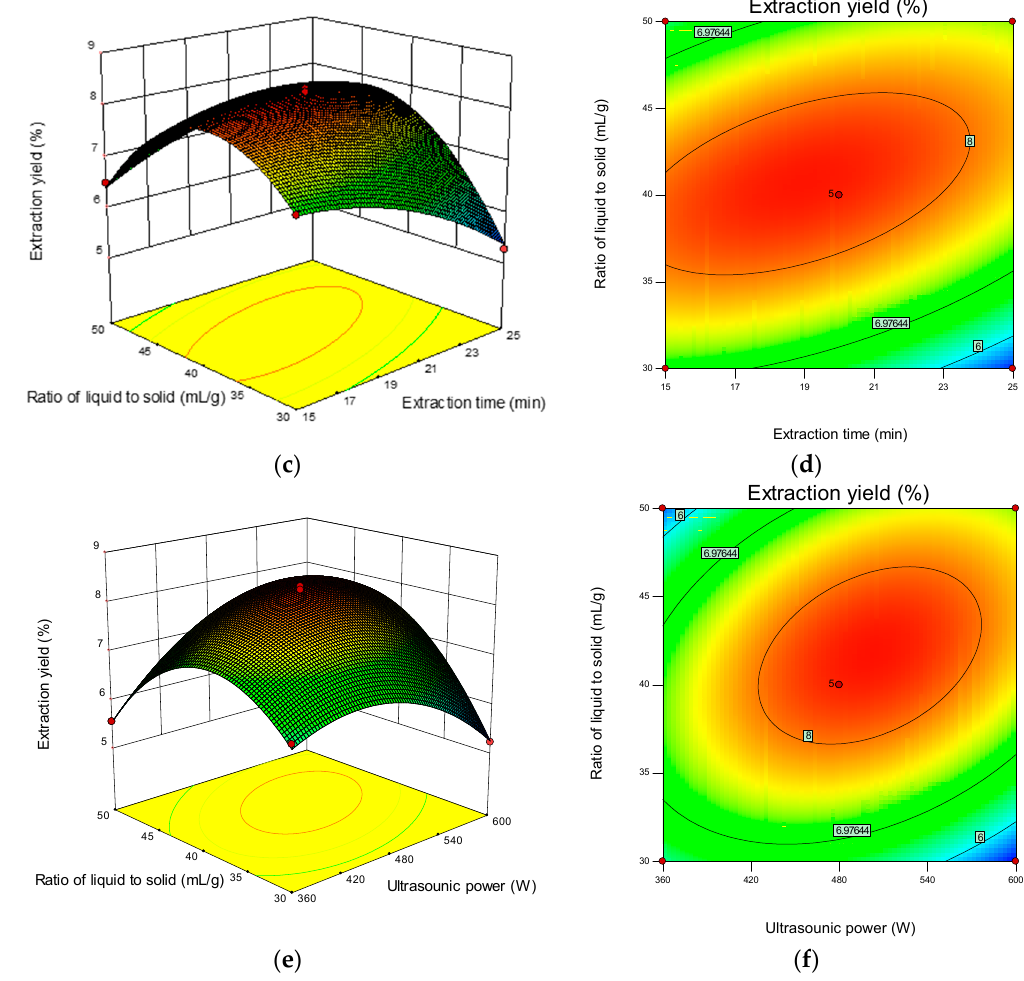
Figure 2. Response surface plots (left) and contour plots (right) showing the interactive effects of different variables on the yield of CMP-U. ( a , b ) Ultrasonic power and extraction time; ( c , d ) ratio of liquid-to-solid and extraction time; ( e , f ) ratio of liquid-to-solid and ultrasonic power.